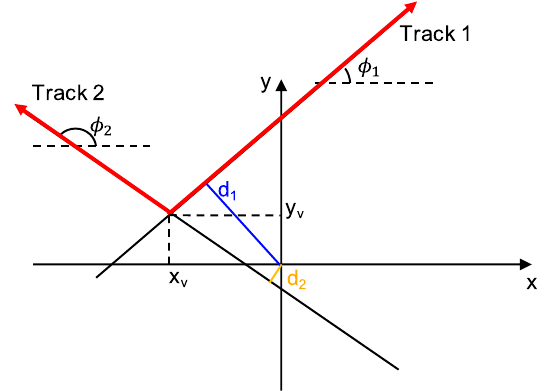
FIG. 8. Two tracks from the same vertex (red lines), with their corresponding d and projected azimuth angle. The arrows indicate the direction of particles emerging from the beam-gas interaction vertex through the BGV